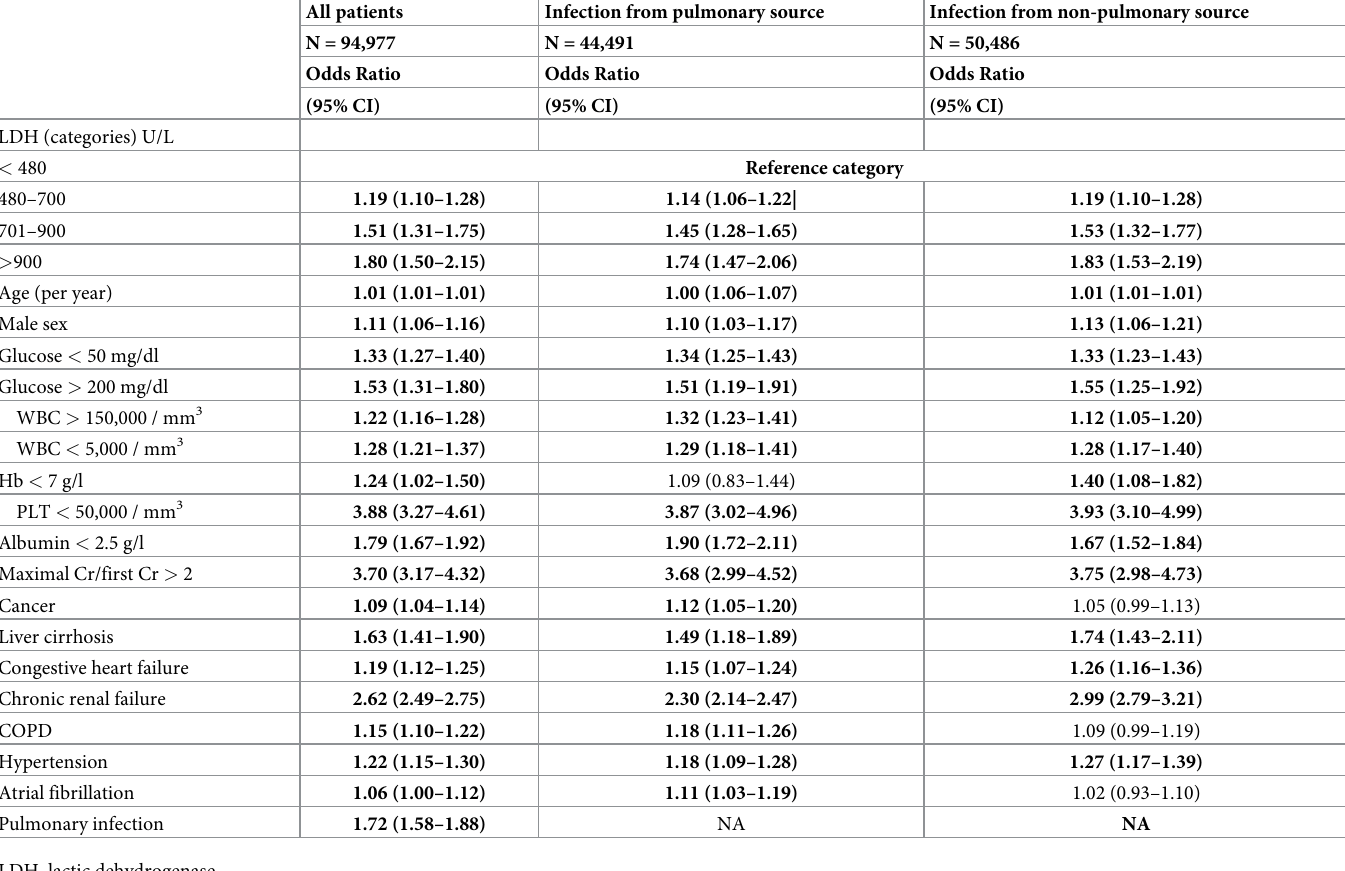
Table 3. Factors associated with target-organ damage (multivariable logistic